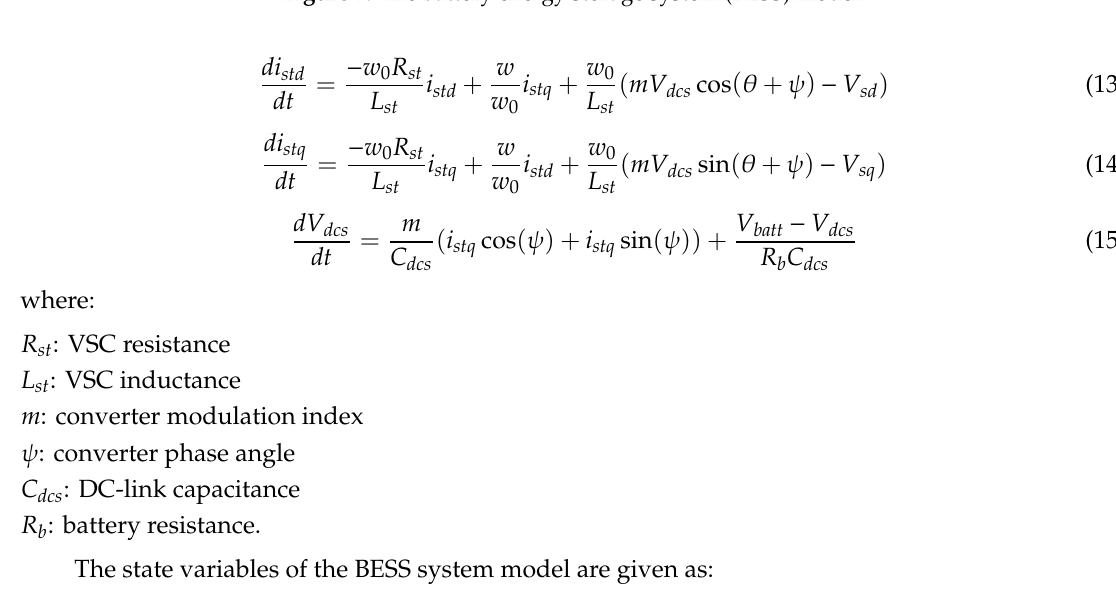
Figure 7. The battery energy storage system (BESS) model.